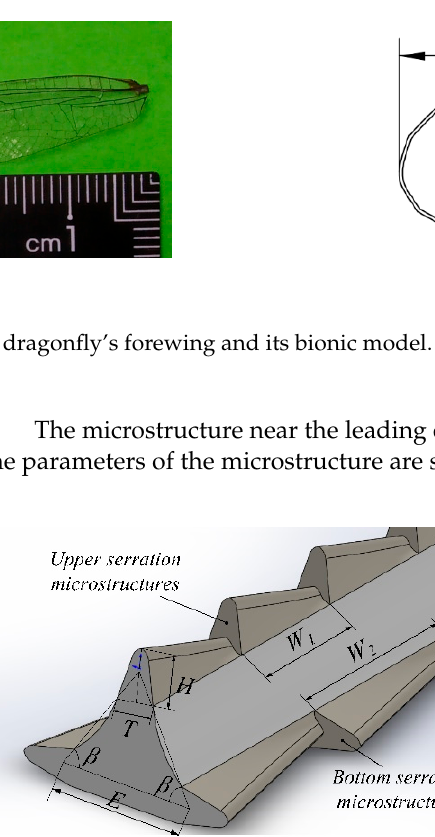
Figure 3. Biomimetic leading-edge microstructure model of a dragonfly wing.